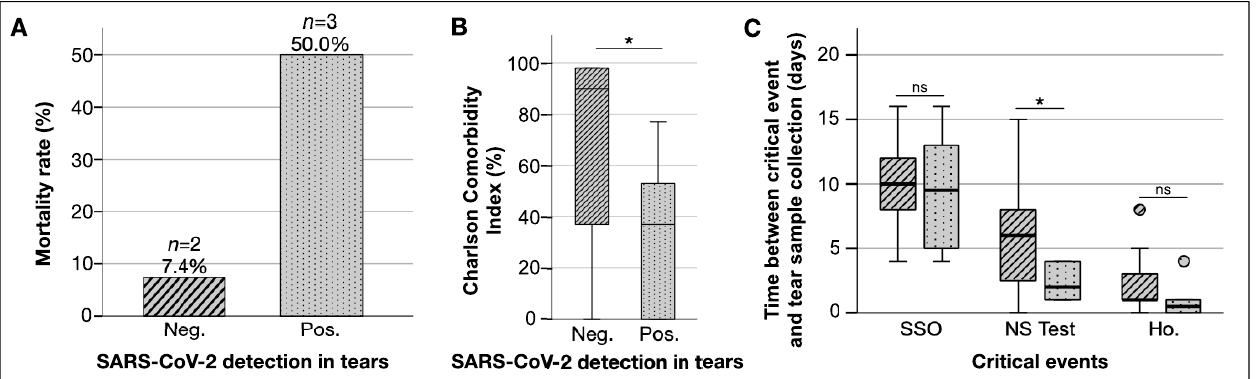
Figure 3. SARS-CoV-2 detection in tear samples is associated with mortality rate, Charlson Comor- bidity Index, and sample collection timing. ( A ) Patients who had viral particles detected in tear samples had a higher mortality rate. ( B ) Boxplot comparing CCI and SARS-CoV-2 detection in tear samples. ( C ) Boxplot comparing critical periods of sample collection. Timing represents the number of days between tear collection and the events on the X -axis. *: p < 0.05. Ho.: hospitalization; Neg.: negative SARS-CoV-2 in tear samples; NS: nasopharyngeal swab; Pos.: positive SARS-CoV-2 in tear samples; SSO: systemic symptoms onset.